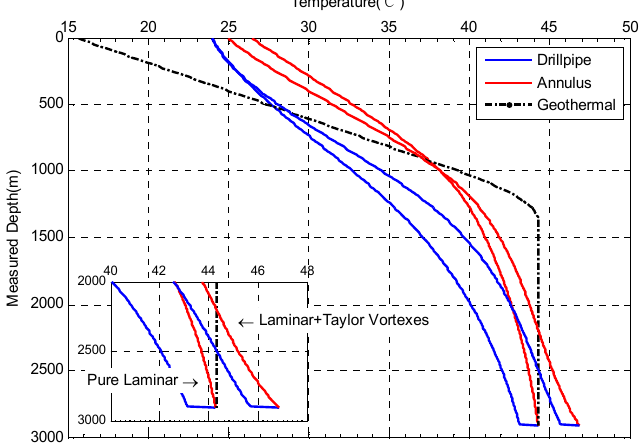
Figure 8. Temperature profile considering the effect of drill pipe rotation. (RPM = 100 r/min).